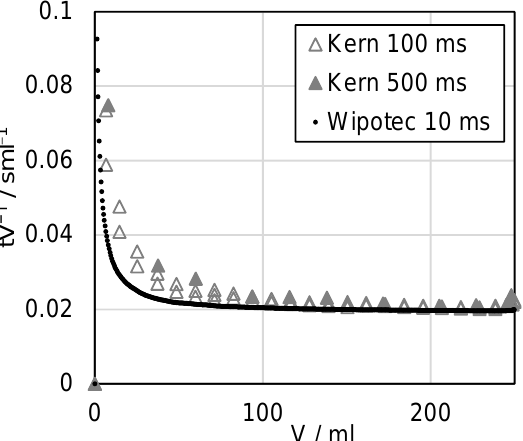
Figure 8. Effects of the balance. Membrane measured with 0 m% at 0.8 bar